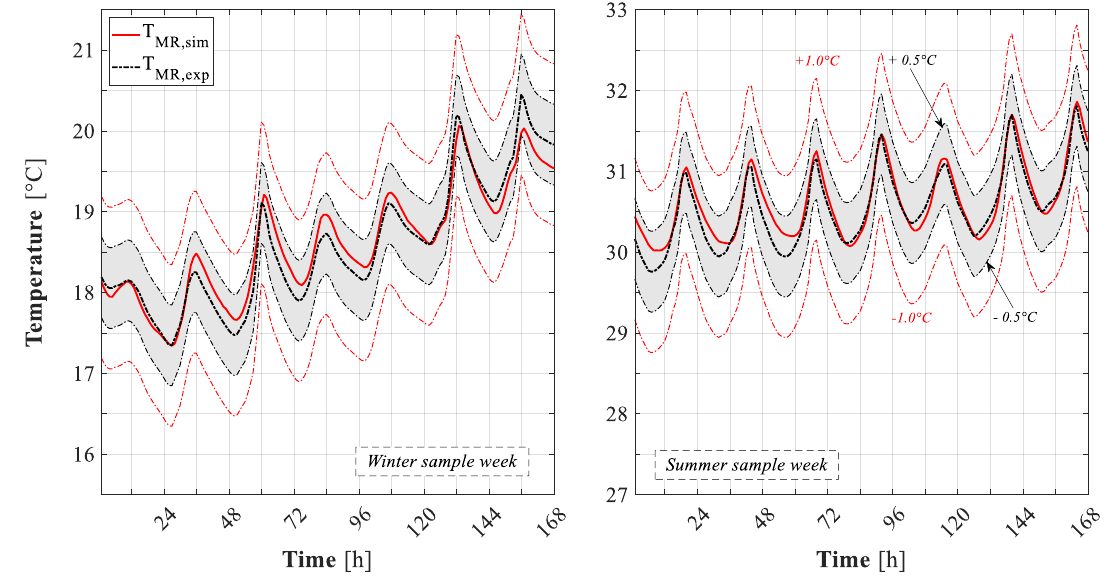
Figure 19. Mean radiant temperature: simulated vs. experimental results (two sample weeks).